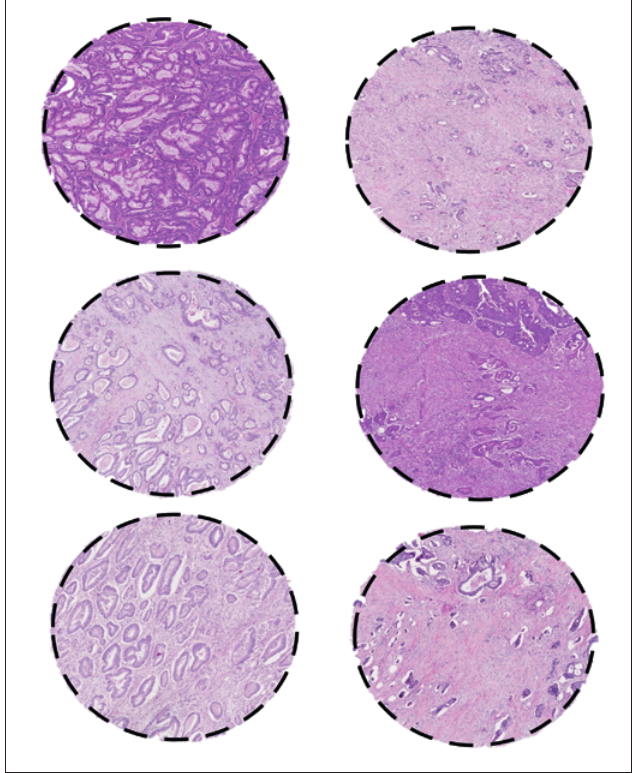
Figure 2. Tumor-stroma proportion. Left column: Examples of TSP ≤ 50% - poor in stroma (Cases No. 382,391 and 284, top to bottom). Right column: Examples of TSP > 50% - rich in stroma (Cases No. 249,119 and 73, top to bottom). Hematoxylin-eosin; magnification